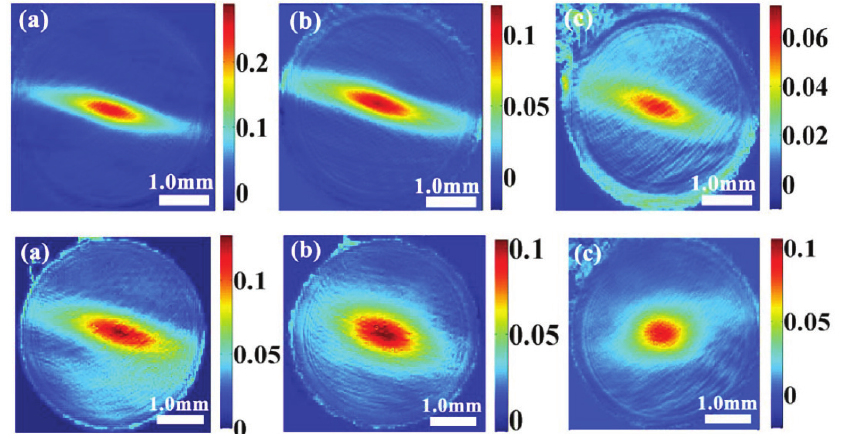
Figure 3. Experimental campaign showing anisotropy ellipse of intensity covariance function. Top row: the same path, height from ground ( a ) 39 cm, ( b ) 84 cm, ( c ) 139 cm. Bottom row: at 84 cm taken over three different paths, in ( a – c ). Reprinted with permission from Reference [37].